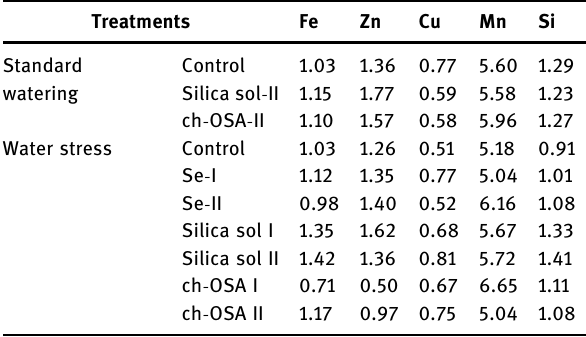
Table 8: The in fl orescence - to - shoot ratio of the content of micro - nutrients and silicon Treatments